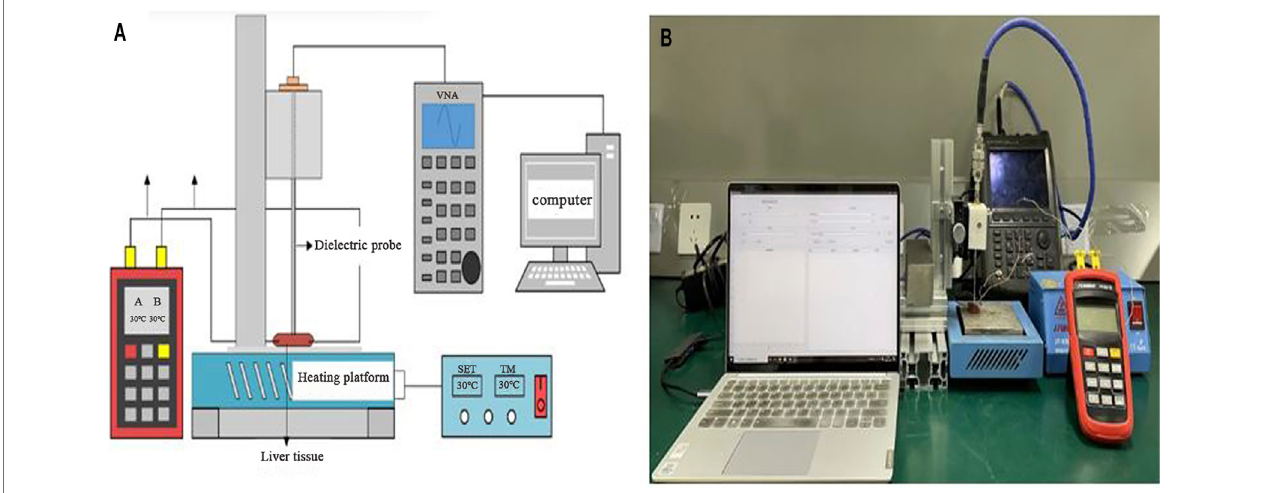
FIGURE1| Schematicdiagram (A) andimage (B) oftheexperimental setupfordielectricpropertymeasurementin exvivo livertissues.Theporcinelivertissuewas placed on the surface of a heating platform, and the dielectric properties testing probe and temperature probes were inserted into liver tissues at an interval of 1.5 cm.